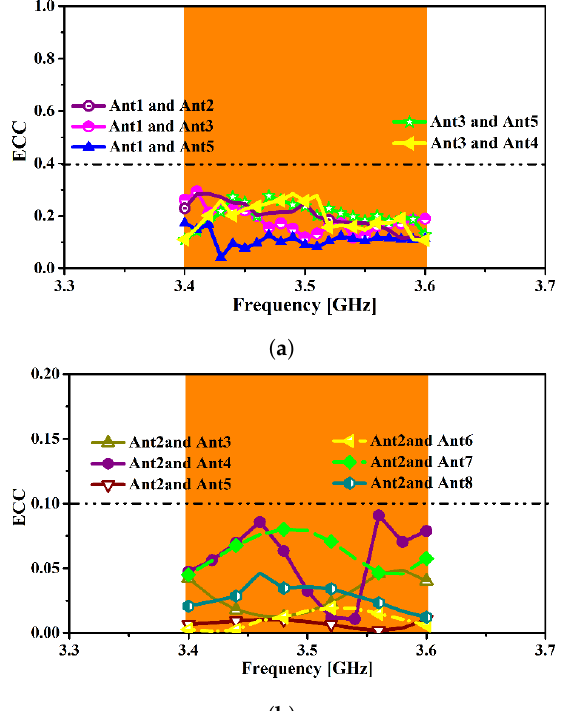
Figure 13. The Envelope Correlation Coefficient (ECC) based on measured far-field results ( a ) ECC for Ant1 with Ant2,Ant3,Ant4 and Ant5, and ( b ) ECC for Ant2 with Ant3,Ant4,Ant5,Ant6,Ant7 and Ant8.